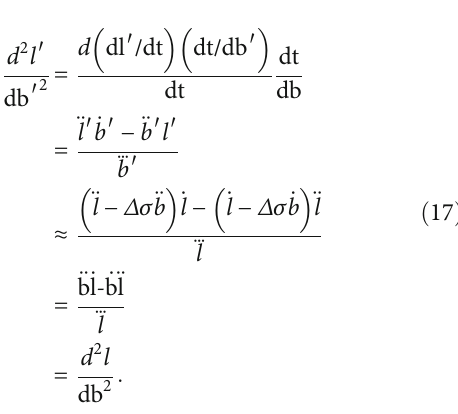
in equilibrium glide, and (b) is the variation of ξ uq